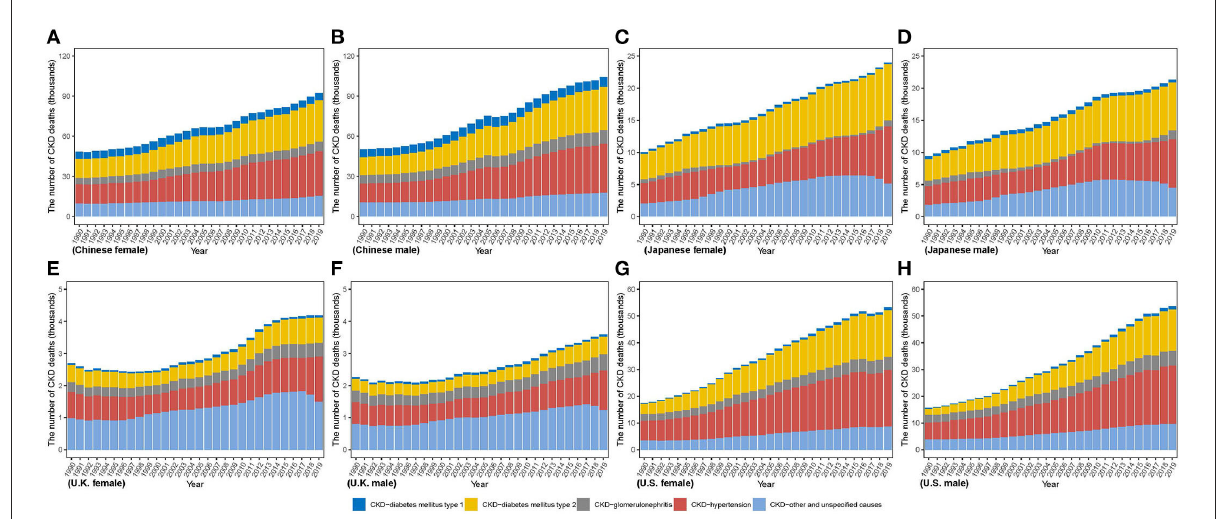
FIGURE3 The number of CKD death cases from 1990 to 2019 in (A) Chinese women (B) Chinese men (C) Japanese women (D) Japanese men (E) U.K. women (F) U.K. men (G) U.S. women (H) U.S.